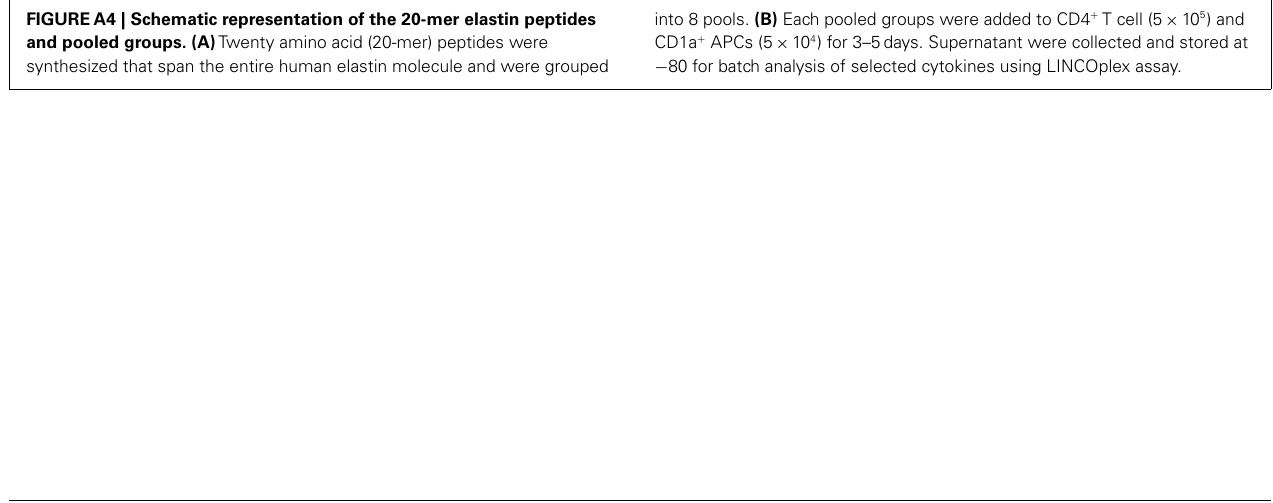
FIGUREA4 | Schematic representation of the 20-mer elastin peptides and pooled groups. (A) Twenty amino acid (20-mer) peptides were synthesized that span the entire human elastin molecule and were grouped